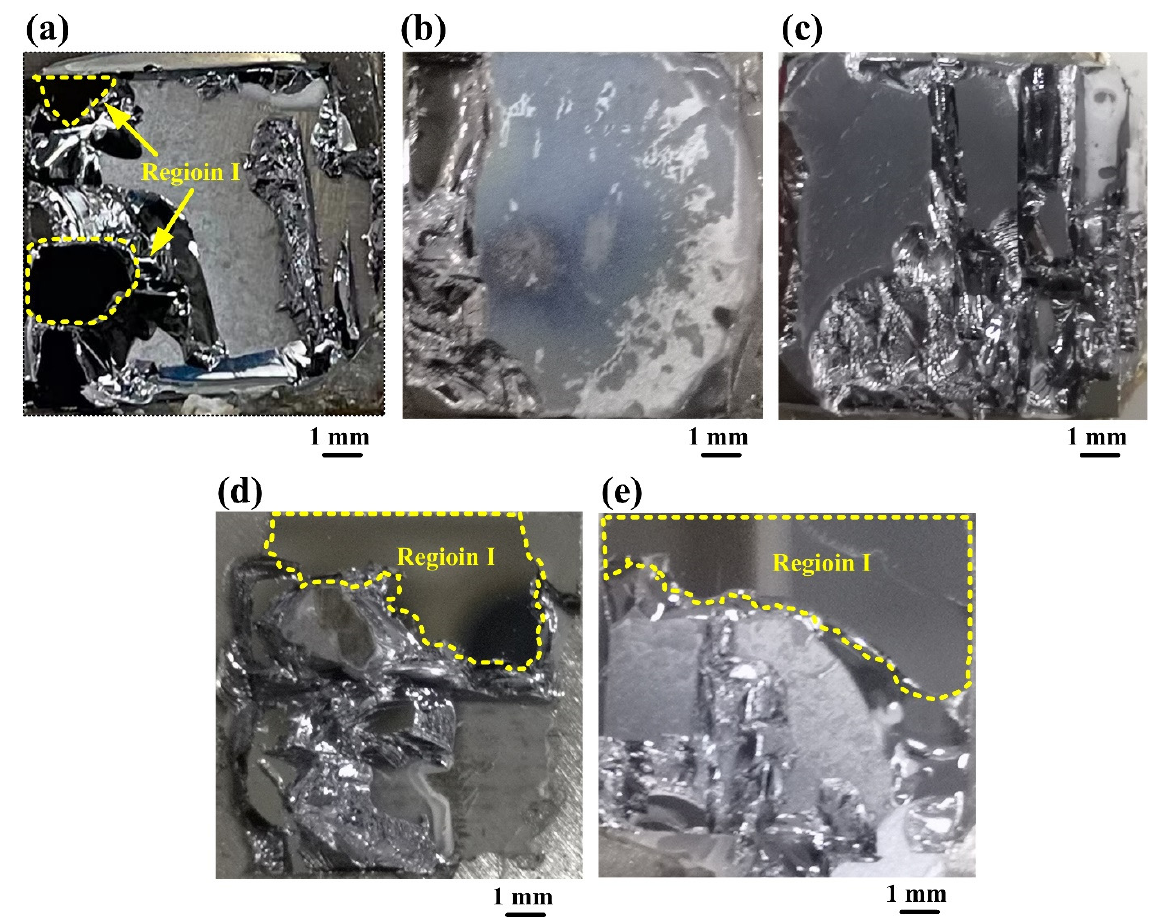
Figure 3. Surface profiles of the fractured parts from the bonded Si-Si specimens activated under the Ar ion beam currents of ( a ) 10 mA, ( b ) 20 mA, ( c ) 30 mA, ( d ) 40 mA and ( e ) 50 mA, respectively, after bonding strength testing.